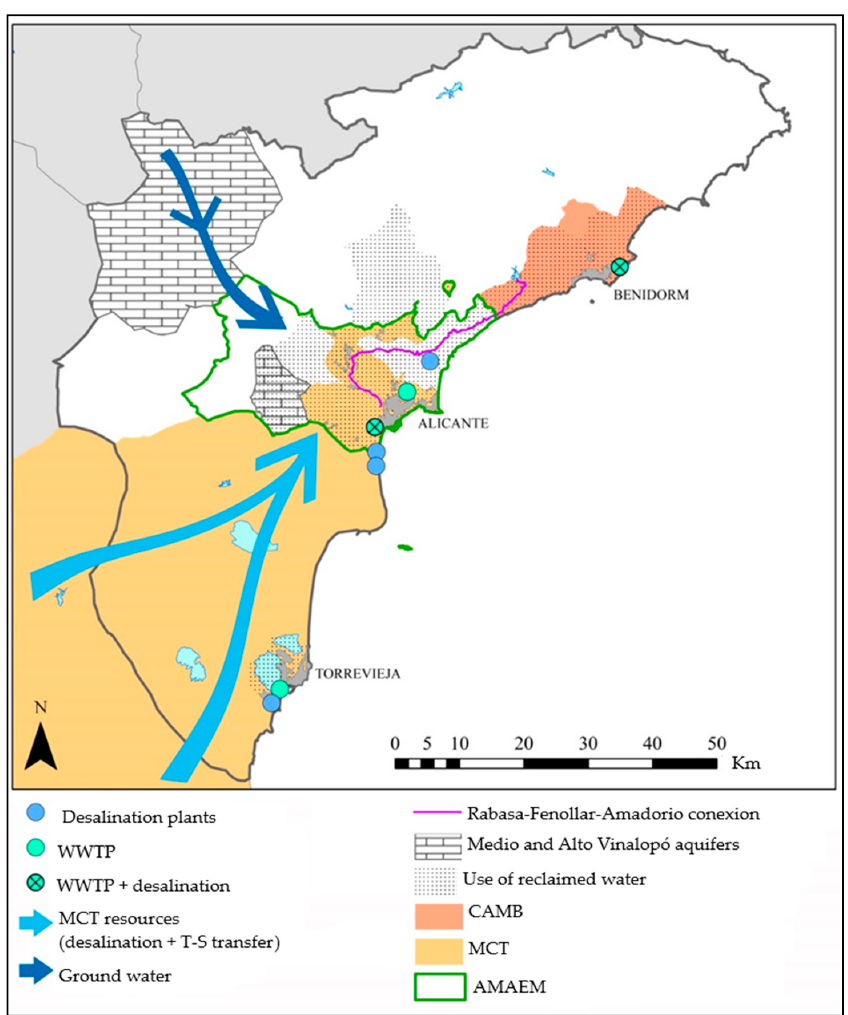
Figure 8. Diagram of the distribution, management and use systems linked to case studies in